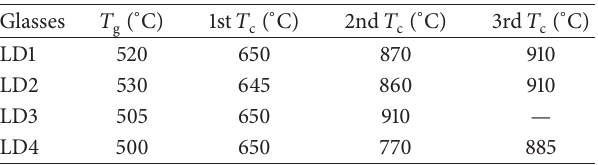
Figure 1: Test geometry of biaxial flexural strength. Table 2: Summary of transition and crystallization temperatures of